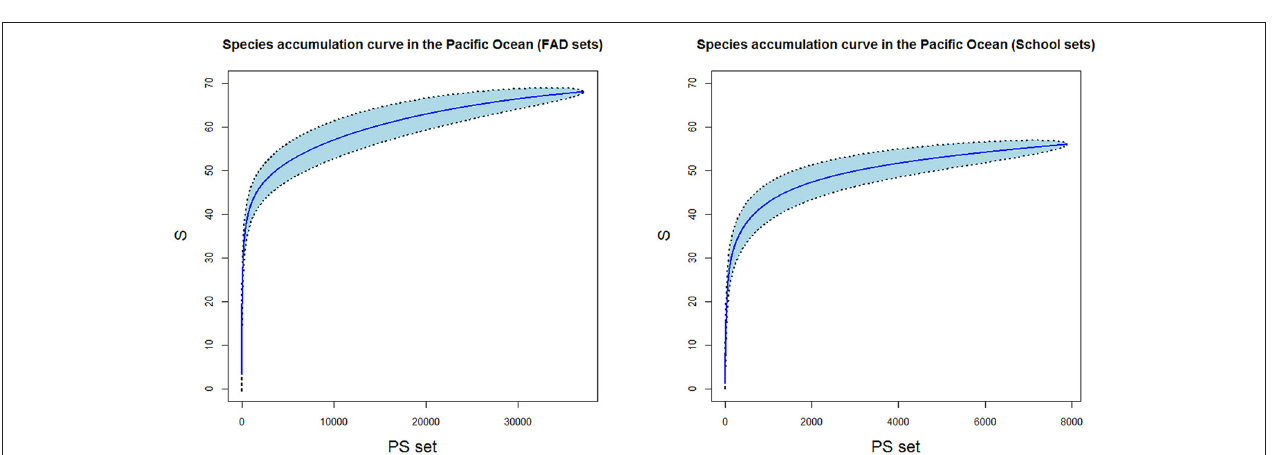
FIGURE 2 | Species accumulation curves in FAD sets (A) and School sets (B) . PS, purse seine set; S, species richness. Blue area corresponds to the standard deviation.